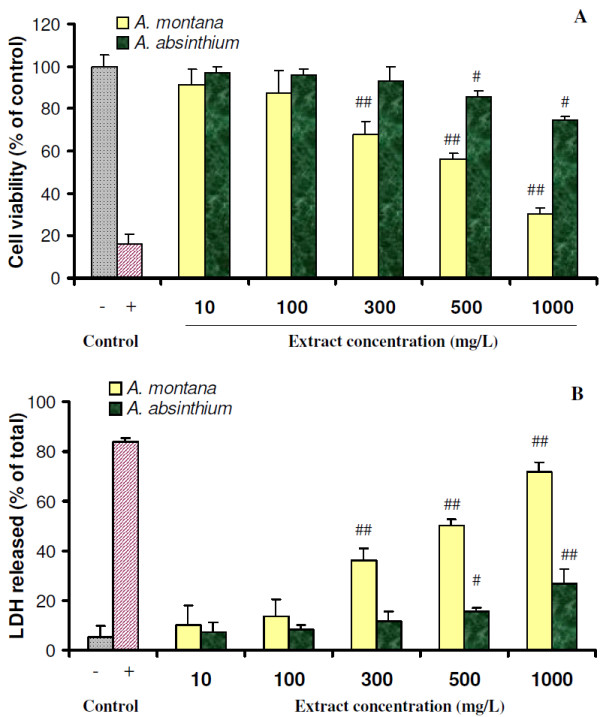
Cell viability of NCTC cells cultured with different concentrations of  A. montana L. and  A. absinthium L. extracts, analyzed by Neutral red (A) and LDH (B) assays. The negative control was represented by cells cultivated in culture plate, in MEM (dotted) and the positive control was represented by cells cultivated in MEM containing 100 μM H2O2 (striped). Results are shown as mean ± SD (n = 6). Pairs of negative control and each sample were analyzed by t-test. Significant differences in each pair are marked with #p < 0.05 or ##p < 0.01.